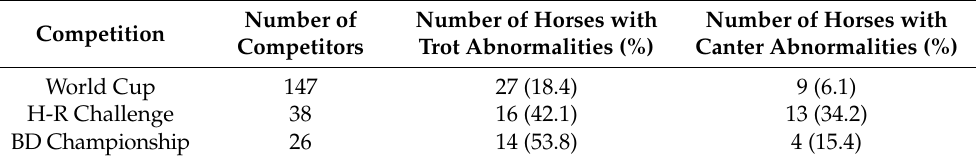
Table 3. Comparison of the frequency of occurrence (percentage, %) of gait abnormalities in trot and canter at the World Cup Grand Prix Western League qualifying competitions ( n = 7) and the finals ( n = 2) 2018–2020 [10], the 2020 Hickstead-Rotterdam (H-R) Grand Prix Challenge and the 2020 British Dressage (BD) Grand Prix National